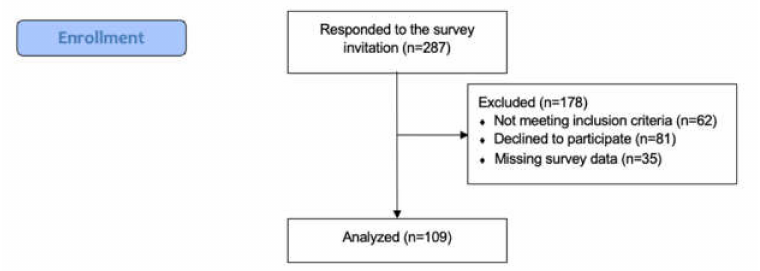
Figure 1. Study enrollment